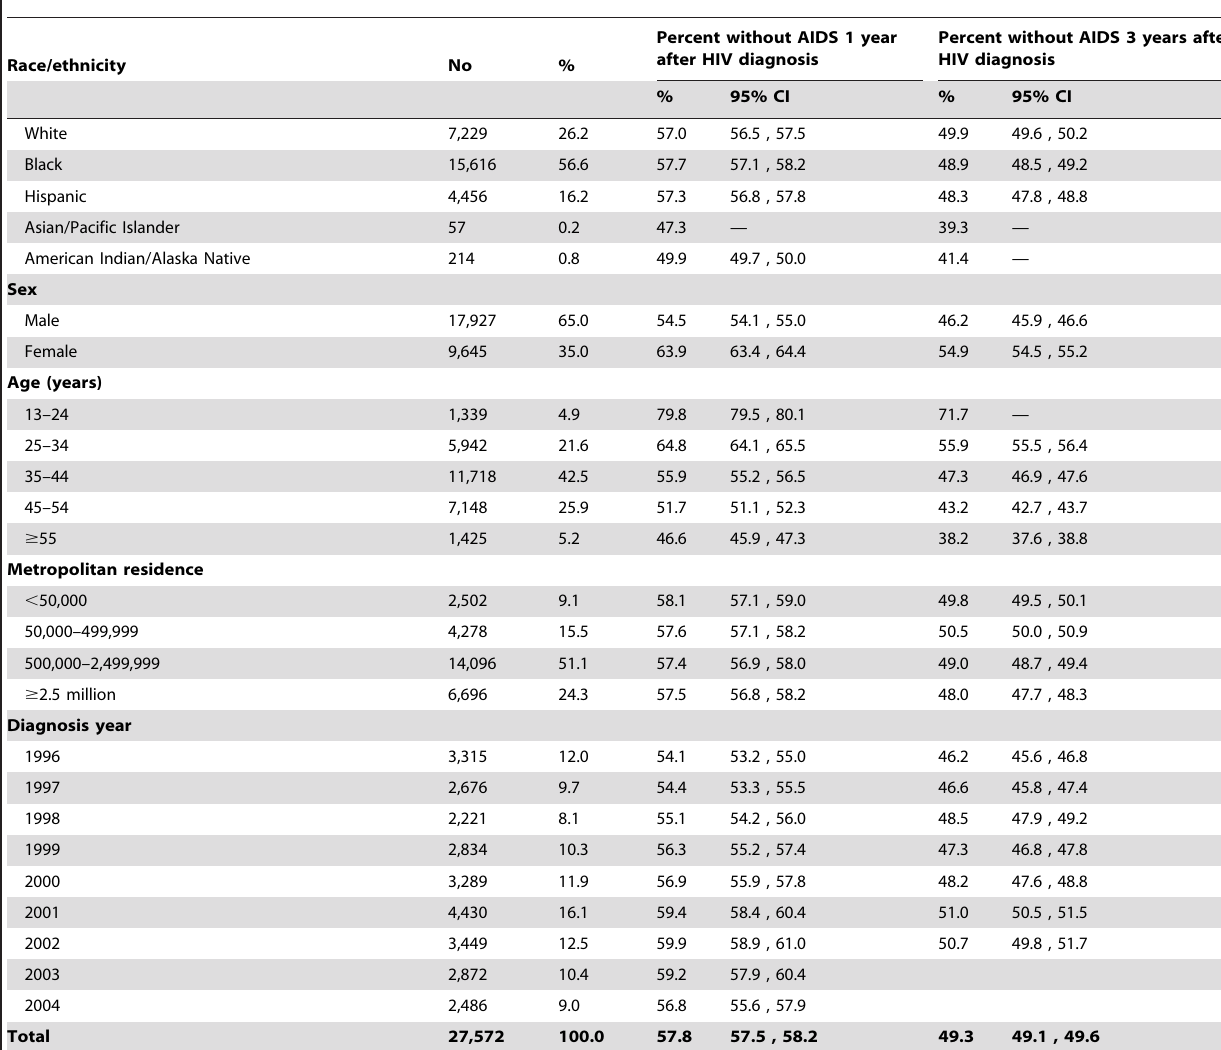
Table 1. Percentage of IDUs with HIV diagnosis who did not progress to AIDS in 1996–2004, 33 U.S. States.